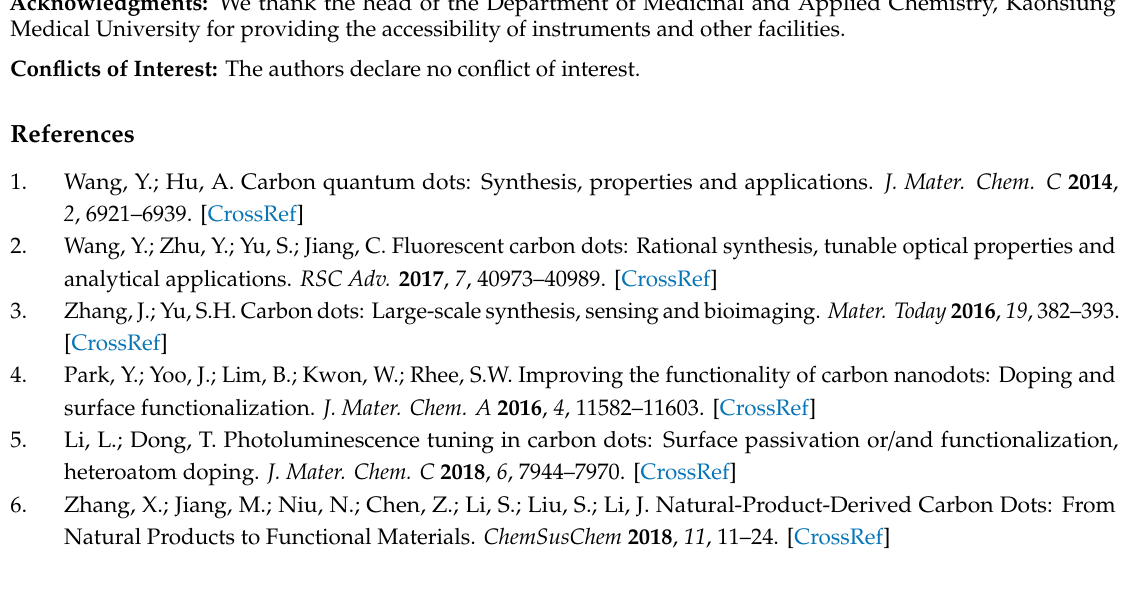
Figure S5: (a) The normalized fluorescence emission spectrum of AC-NCDs and UV-vis absorption spectrum of MO, and (b) UV-vis spectra comparison of AC-NCDs, MO, and AC-NCDs / MO system (pH 2, 5, and 12). The MO concentration was 50 µ M, Figure S6: FRET measurement according to the equation E = 1 − (F D / F D ’). The excitation wavelength was 360 nm; the integrated fluorescence intensity was calculated from 360 nm to 650 nm with (a) 50 µ M MO and (b) 100 µ M MO, Figure S7: The appearance of AC-NCDs / MO’ solution with di ff erent pH values (MO concentration was 50 µ M), Table S1: The comparison of starting materials, synthetic methods, Table S2: The comparison of this method with other methods for the probing of MO, Table S3: The probing of MO in tap water samples (n =